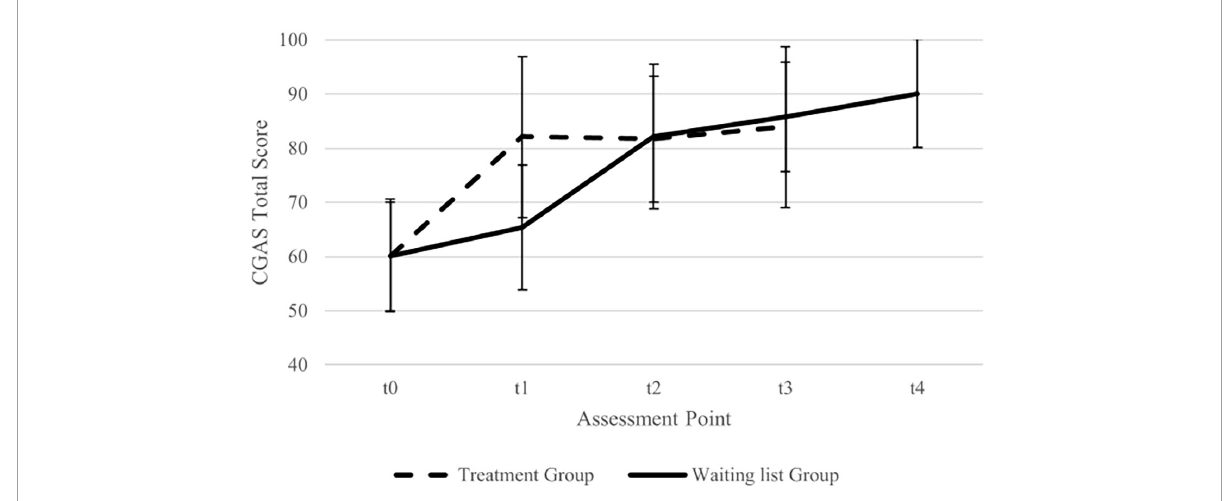
FIGURE3 Imputed data for total Children’s Global Assessment Scale (CGAS) mean scores (with standard deviation) for treatment group and waiting list group. Assessment points treatment group: t0 = baseline, t1 = post-treatment, t2 = 16 weeks follow up, t3 = 32 weeks follow-up. Assessment points waiting list group: t0 = Baseline, t1 = pre treatment, t2 = post-treatment, t3 = 16 weeks follow-up, t4 = 32 weeks follow